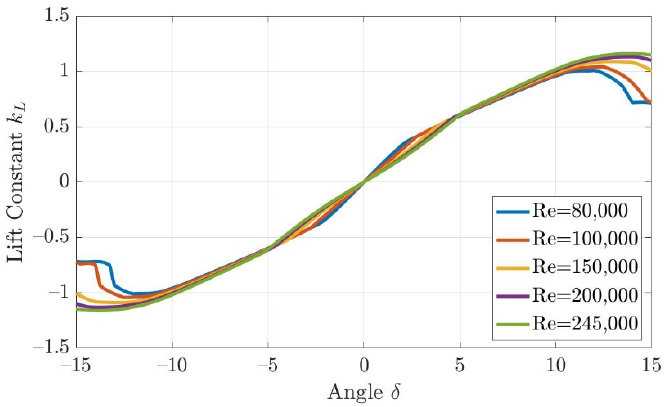
Figure 7. The lift constant k L with respect to turning angle δ .